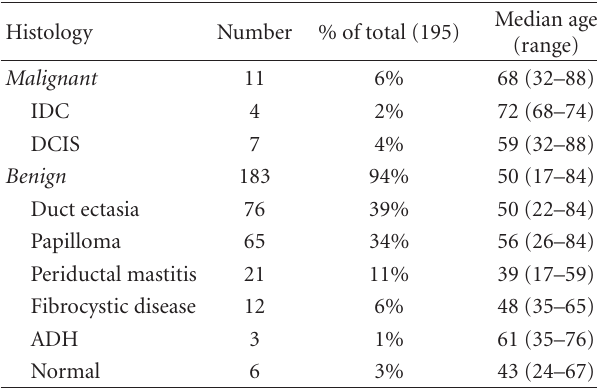
Table 1: Histology of duct excision